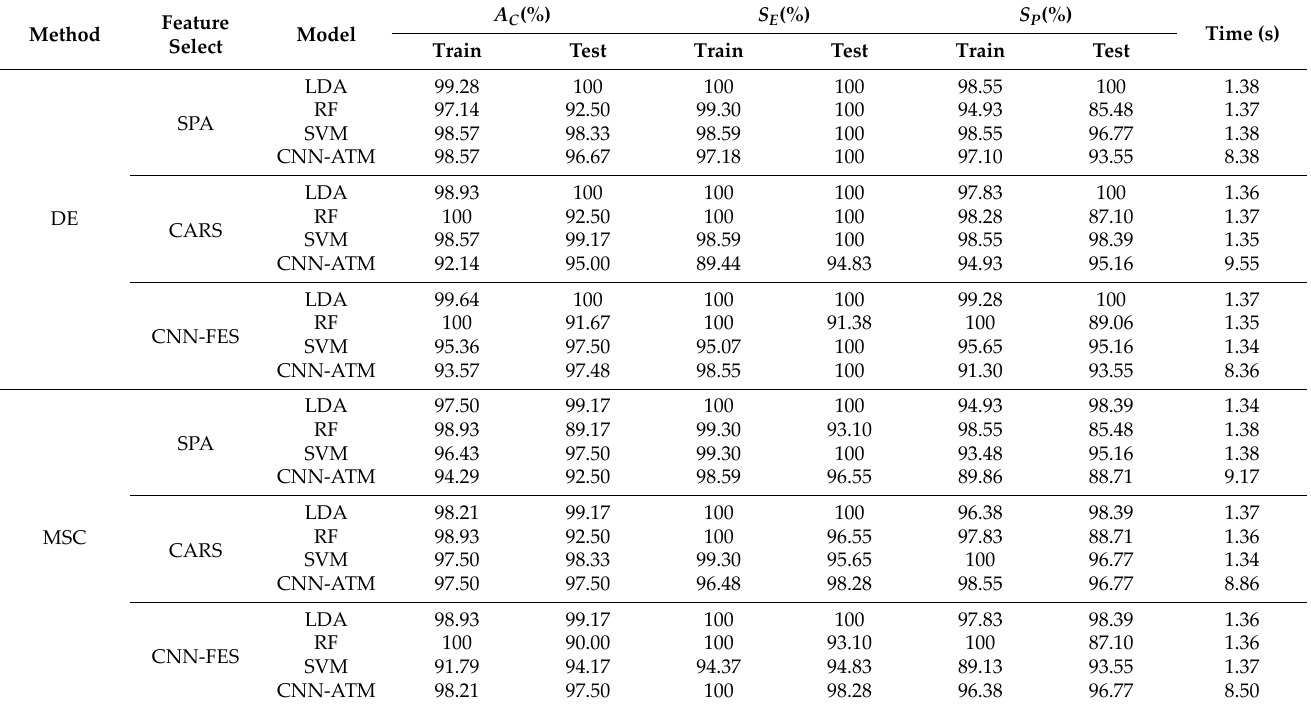
Table 3. Detection results based on feature